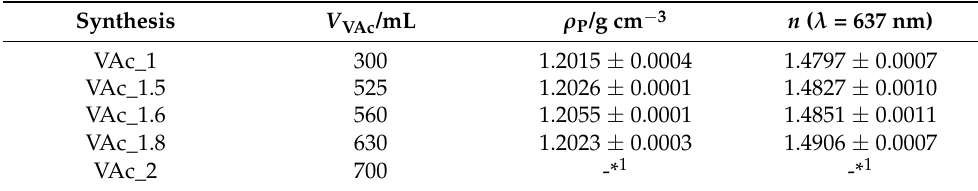
Table 3. Total volumes of dosed monomer V VAc , extrapolated density ρ P and refractive index n (at λ = 637 nm) of the particles for each